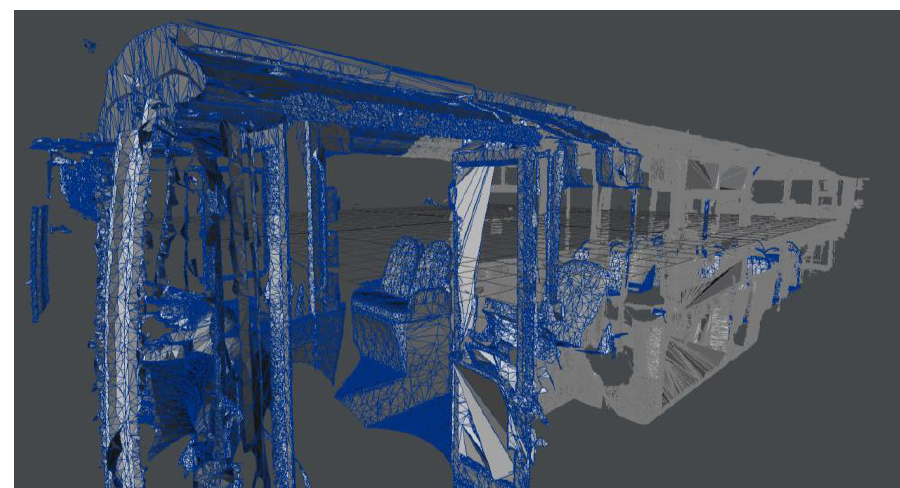
Figure 3. Tessellated ‘point cloud’ resulting from three scans combined to create the bus geometry.